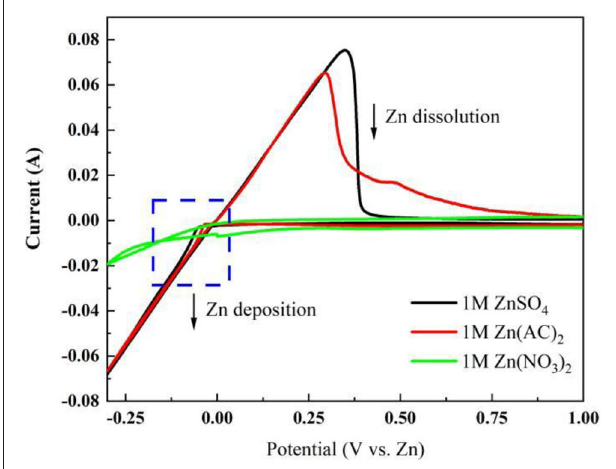
FIGURE 1 | Cyclic voltammetry characterization in a three-electrode system at a scan rate of 1mV s − 1 in different electrolytes.